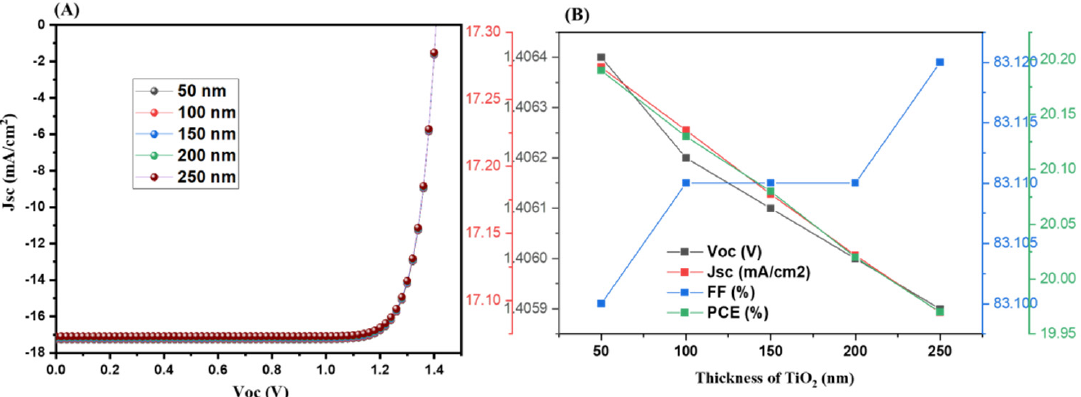
Figure 3. J-V curves ( A ) and photovoltaic parameters ( B ) of FTO/TiO 2 (varying)/NH 3 (CH 2 )NH 3 MnCl 4 Figure 3. J ‐ V curves ( A ) and photovoltaic parameters ( B ) of FTO/TiO 2 (vary ‐ (600 nm)/Spiro-OMeTAD (300 nm)/Au. ing)/NH 3 (CH 2 )NH 3 MnCl 4 (600 nm)/Spiro ‐ OMeTAD (300 nm)/Au.